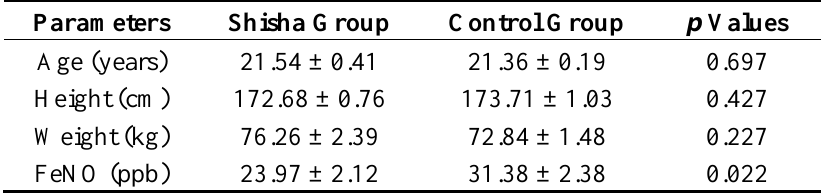
Table 2. Comparison of Fractional Exhaled Nitric Oxide (FeNO) between Shisha smokers compared to their matched control